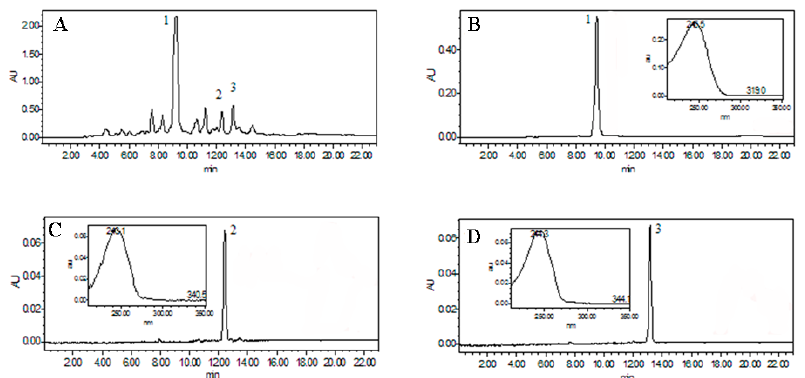
Figure 2. ( A ) HPLC chromatogram of the ethyl acetate extract from D. glaucescens ; ( B – D ) HPLC analyses and UV spectrum of three ecdysteroids from D. glaucescens puri fi ed with HSCCC.